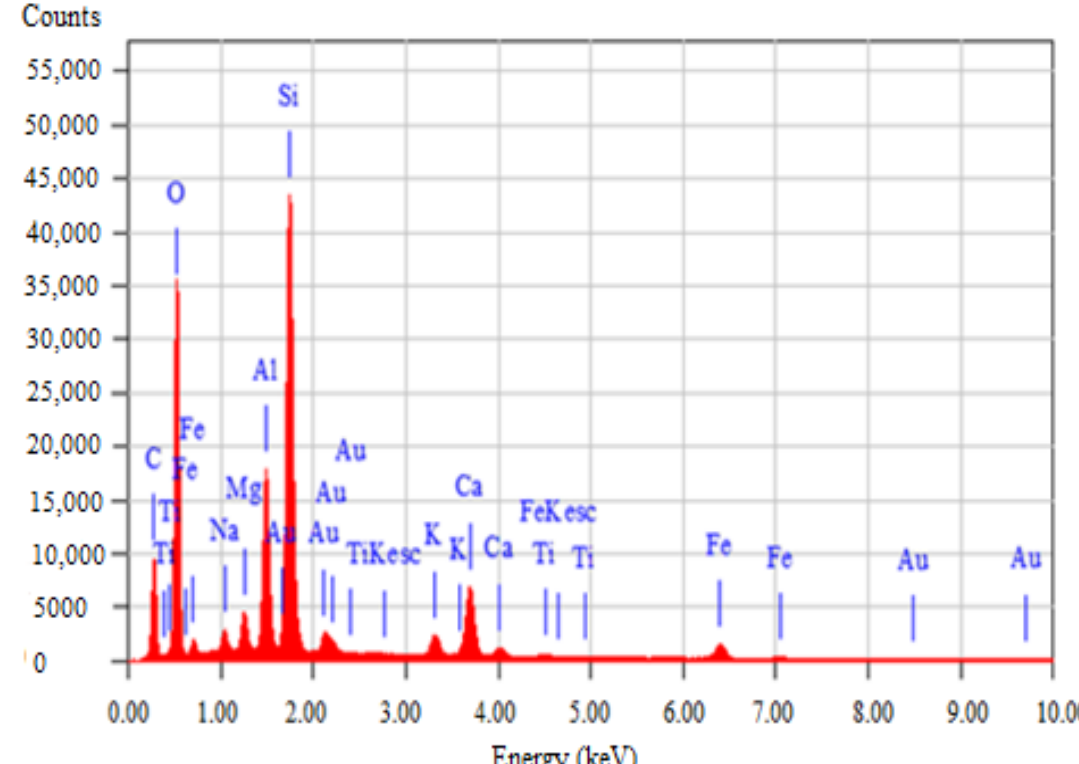
Figure 11. Elemental analysis of the fired ceramic sample with loam from the Ukrainian deposit.